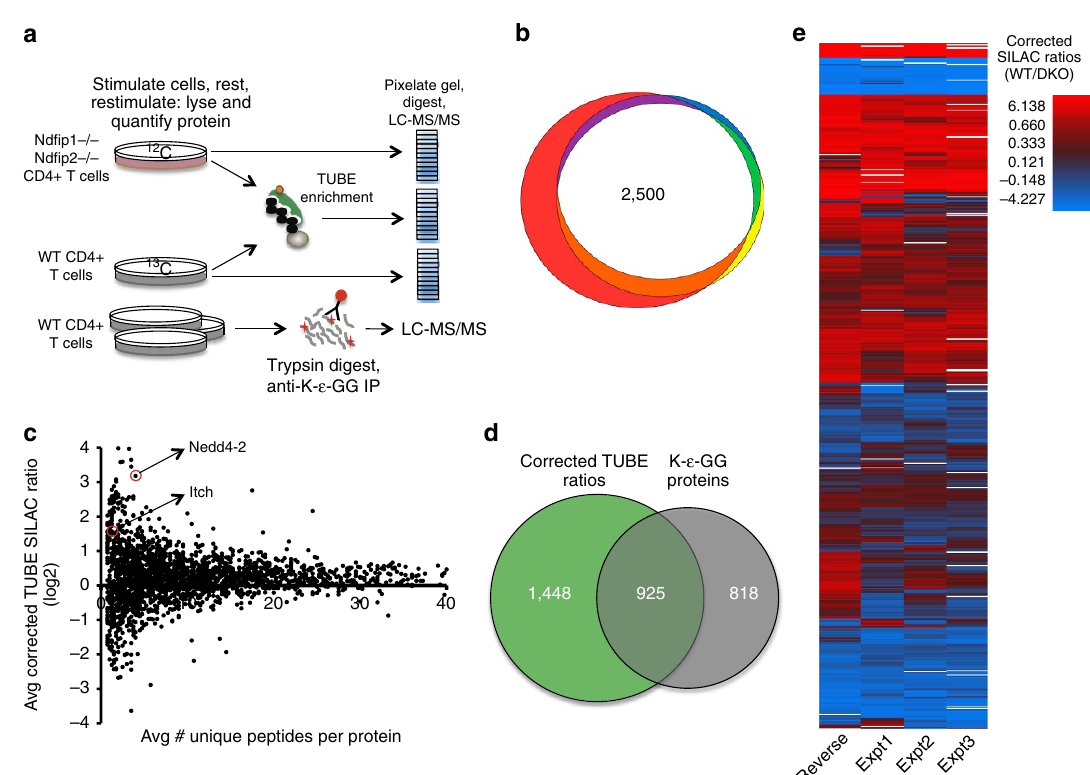
Figure 5 | Identification of differential ubiquitylation by proteomics. ( a ) Schematic of the three proteomics methods used. ( b ) Area proportional Venn diagram illustrating the reproducibility of proteins identified as having SILAC ratios after TUBE enrichment in three out of four biological replicates. ( c ) SILAC–TUBE ratios (WT/DKO) for each protein were corrected using ‘input’ ratio (DKO/WT) as calculated by label-free quantification of whole proteome DKO and WTdata sets. The average corrected ratio is plotted against the average number of unique peptides observed per protein across four whole proteome LC-MS/MS experiments. Plot limited to 40 average unique peptides for clarity. Itch and Nedd4-2 (indicated) have log2 transformed corrected ratio 4 1 at the protein level. Itch ¼ 1.57 ± 0.17 and Nedd4-2 ¼ 3.18 ± 0.226. ( d ) Overlap of proteins with corrected SILAC–TUBE ratios (observed in at least three experiments) and proteins identified with at least one K- e -GG peptide (in at least one of the three K- e -GG immunoprecipitation experiments). ( e ) Heat map illustrating reproducibility of corrected SILAC–TUBE ratios (WT/DKO, log2 transformed, observed in at least three of four experiments) for proteins identified with K- e -GG peptides. Reverse ¼ SILAC labeling